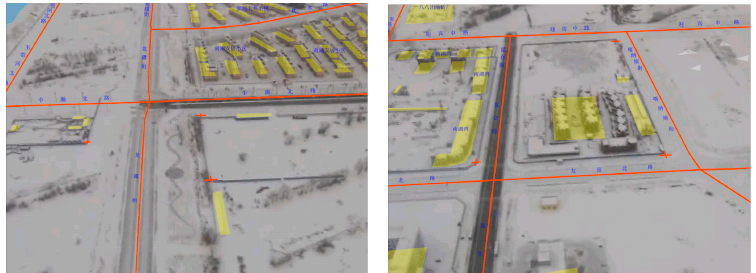
Figure 11. The points selected for the accuracy assessment.